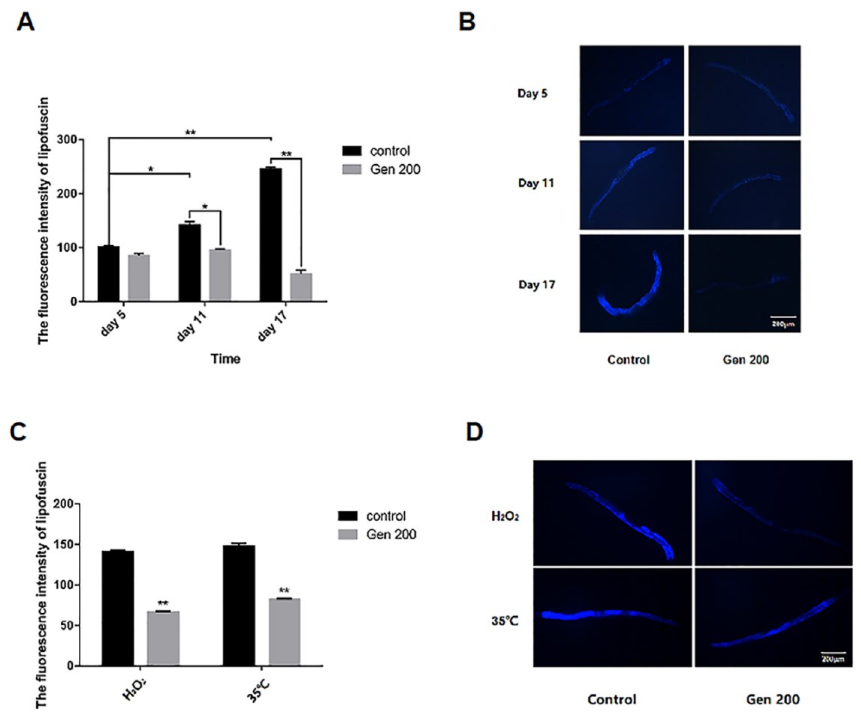
Figure 2. The effect of 200 µ M genistein on lipofuscin accumulation in C. elegans under control, H 2 O 2 and 35 ◦ C conditions. ( A ) Relative fluorescence intensity of lipofuscin in C. elegans (% of control) on days 5, 7, and 11 under control conditions. ( B ) Photomicrographs of lipofuscin fluorescence in C. elegans on days 5, 7, and 11 under control conditions. ( C ) Relative fluorescence intensity of lipofuscin in C. elegans on day 5 in H 2 O 2 and 35 ◦ C conditions. ( D ) Photomicrograph of lipofuscin fluorescence in C. elegans on day 5 in H 2 O 2 and 35 ◦ C conditions ( * p < 0.05; ** p <